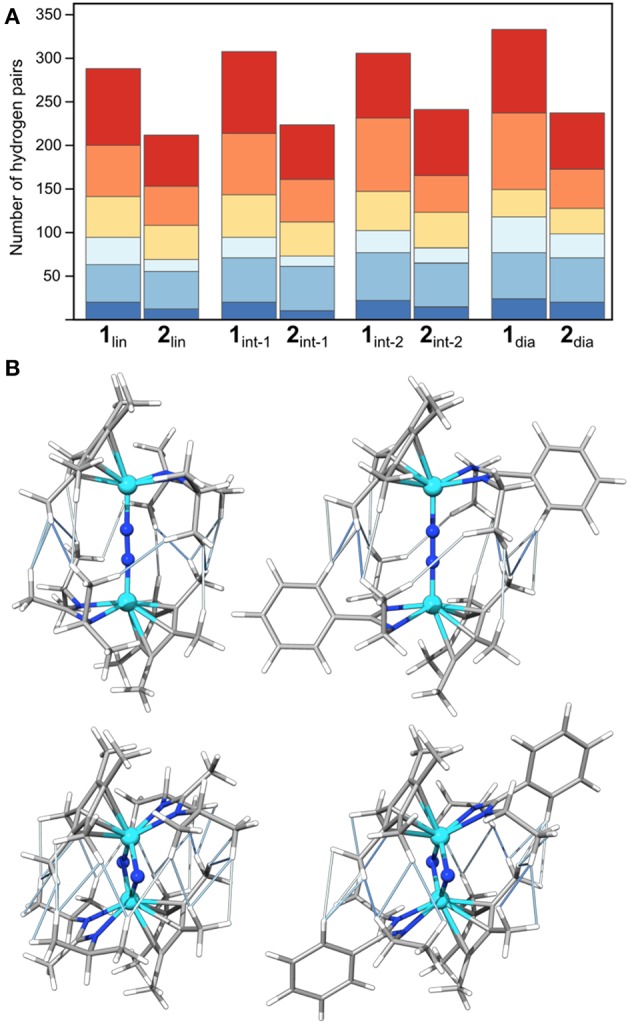
Visualization of the number of hydrogen pairs along the isomerization pathway of 1 and 2, (A) in terms of absolute numbers in bins of 1.8–2.2 Å (dark blue), 2.2–2.6 Å (middle blue), 2.6–3.0 Å (light blue), 3.0–3.4 Å (yellow), 3.4–3.8 Å (orange), 3.8–4.2 Å (red), and (B) as a representation of the actual geometric interactions in 1lin (top left), 1dia (top right), 2lin (bottom left) and 2dia (bottom right); H-H interactions are shown as thin lines in dark blue (1.8–2.2 Å), middle blue (2.2–2.6 Å), and light blue (2.6–3.0 Å). Color code for atoms is Mo: light blue N: blue, C: gray, H light gray.